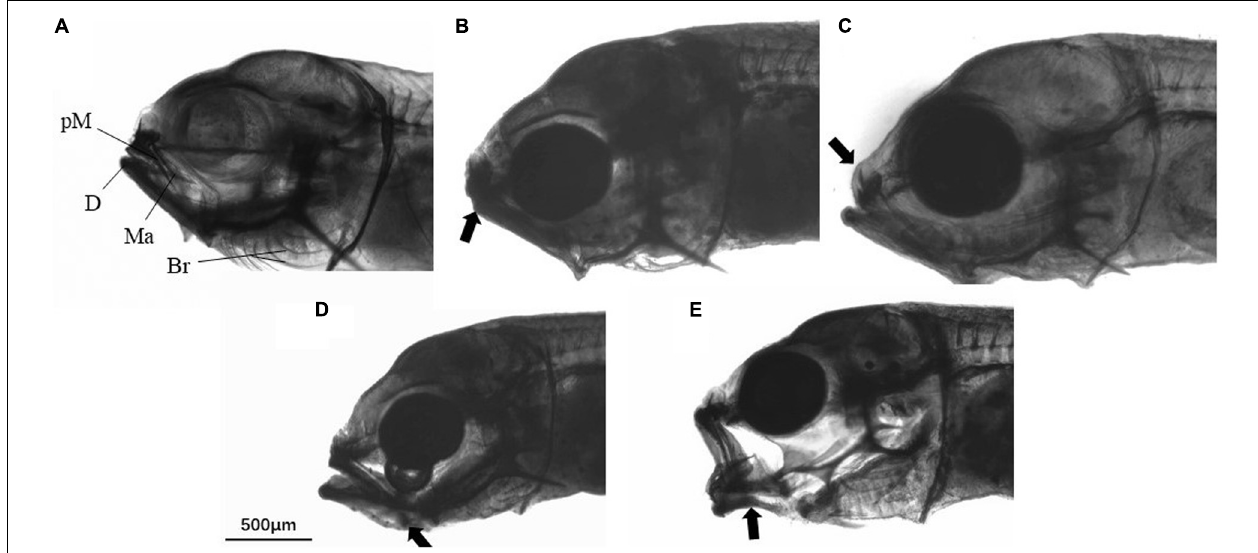
FIGURE 1 | Golden pompano larvae with different jaw malformation index scores. (A) Score 0, (B) score 0.5, (C) score 1, (D) score 2, and (E) score 3. Abbreviations: pM, Premaxilla; Ma, maxilla; D, dentary; Br, branchiostegal rays. The arrow points to the location of the deformity.